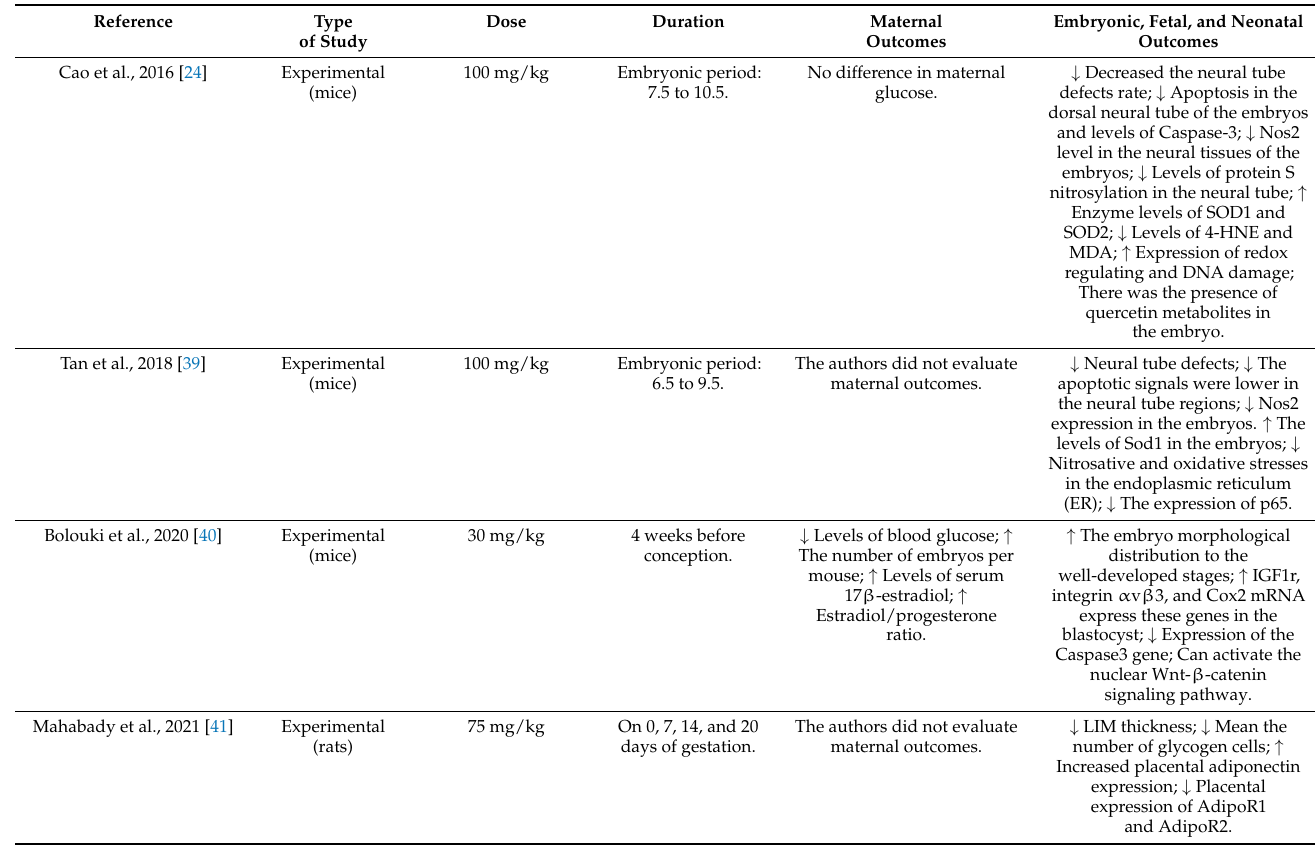
Table 1. Studies using quercetin in the treatment of diabetes mellitus during pregnancy. The up arrow ↑ represents increase, down arrow ↓ represents